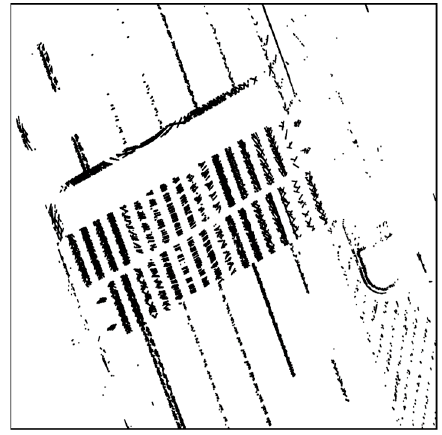
Figure 7. Result of road-marking extraction.